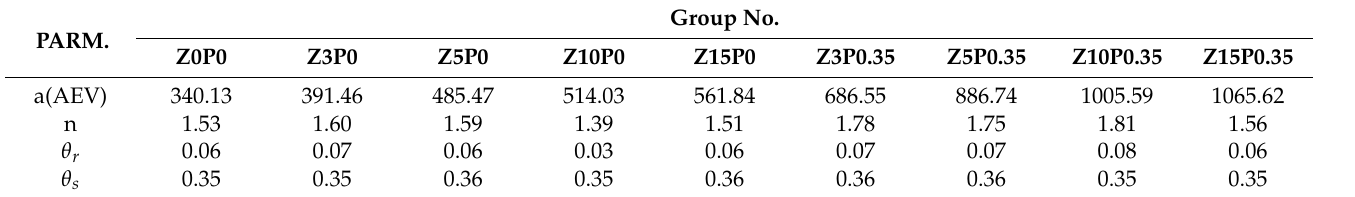
Table 6. Fitting